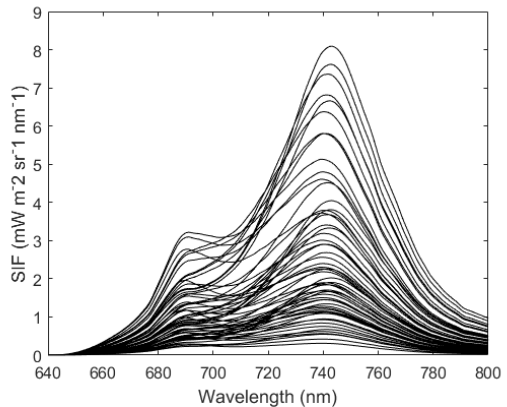
Figure 4. Fluorescence spectra at the top-of-canopy (TOC) level as simulated using the SCOPE model.